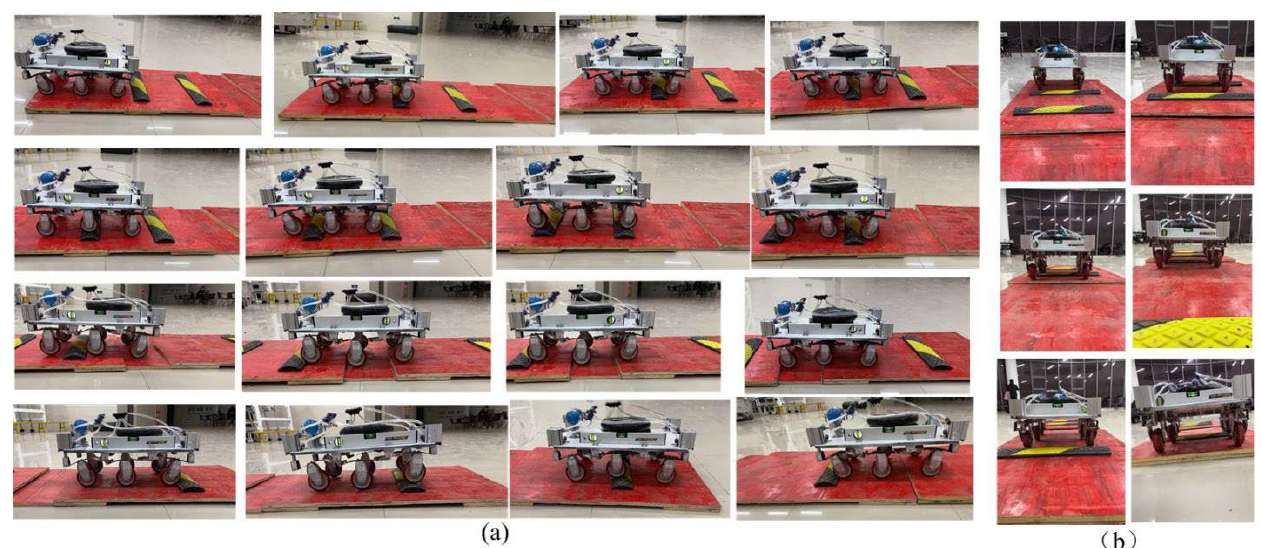
Figure 23. Tests of floating chassis on ( a ) longitudinal direction and ( b ) transverse direction pothole pavement.